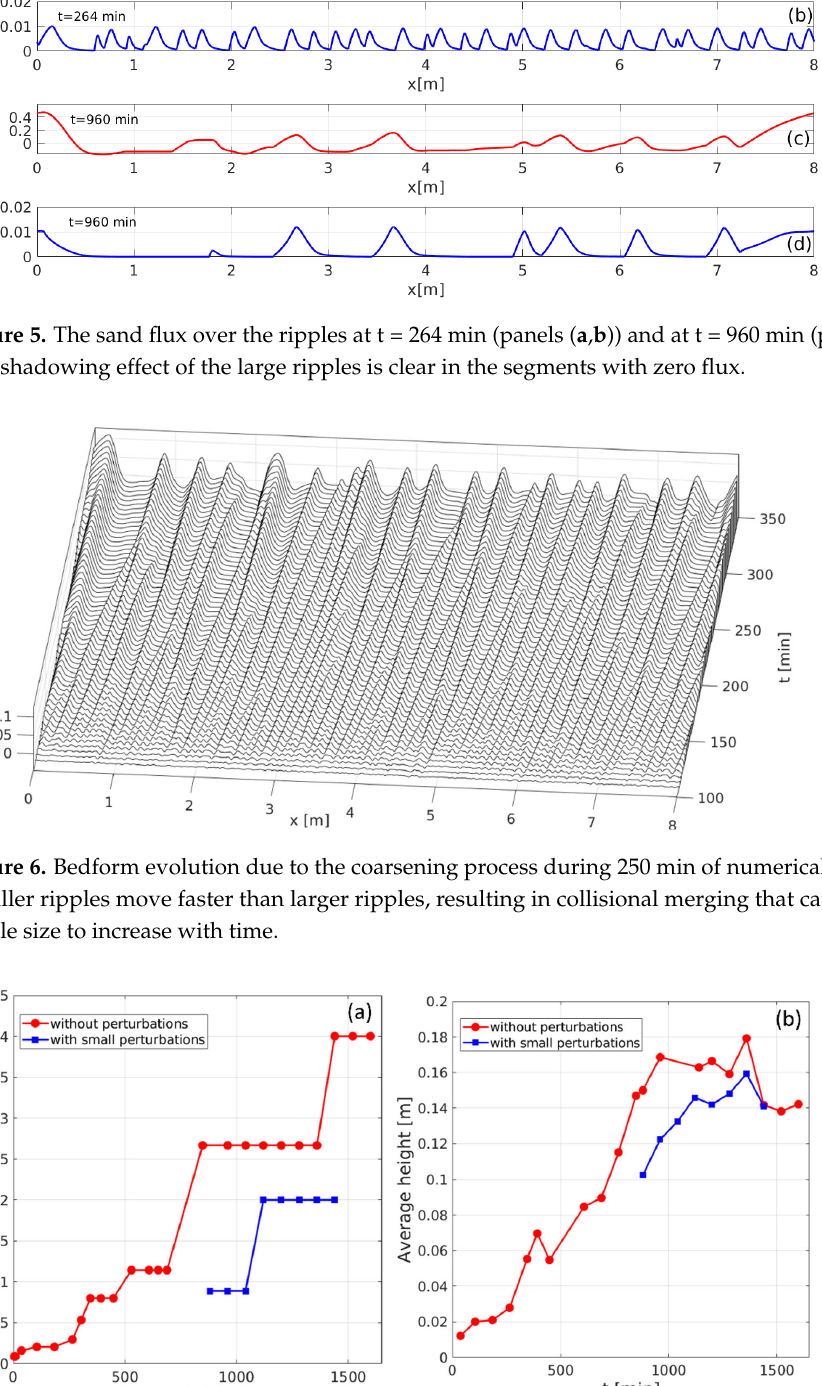
Figure 5. The sand flux over the ripples at t = 264 min (panels ( a , b )) and at t = 960 min (panels ( c , d )). The shadowing effect of the large ripples is clear in the segments with zero flux.